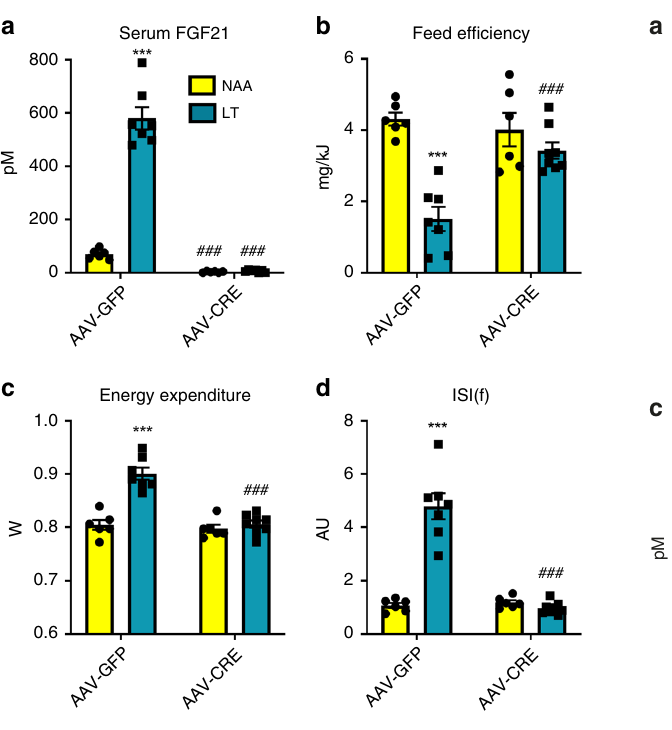
Fig. 6 Liver-derived fi broblast growth factor 21 is necessary for the systemic metabolic remodelling with dietary threonine restriction. a Serum fi broblast growth factor 21 (FGF21) levels of Fgf21 fl / fl mice at the